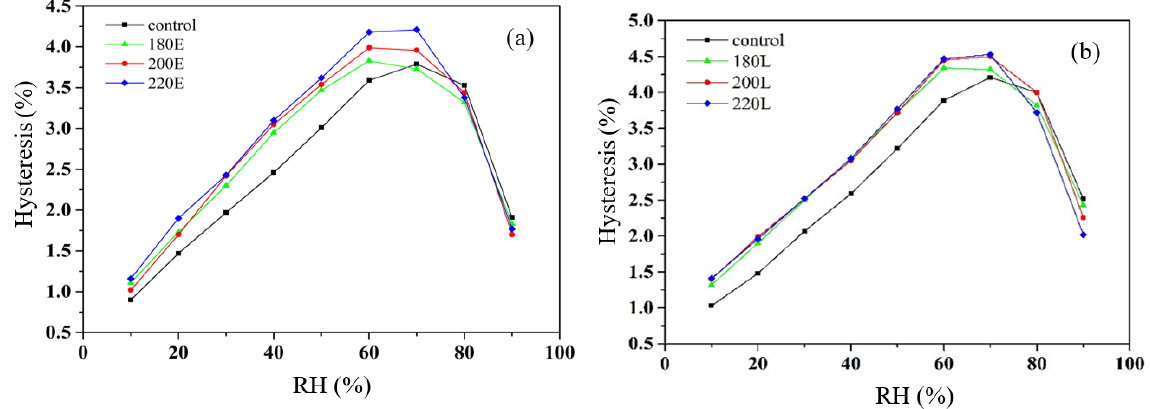
Figure 4. Sorption hysteresis of untreated and vacuum heat-treated EW ( a ) and LW ( b ).